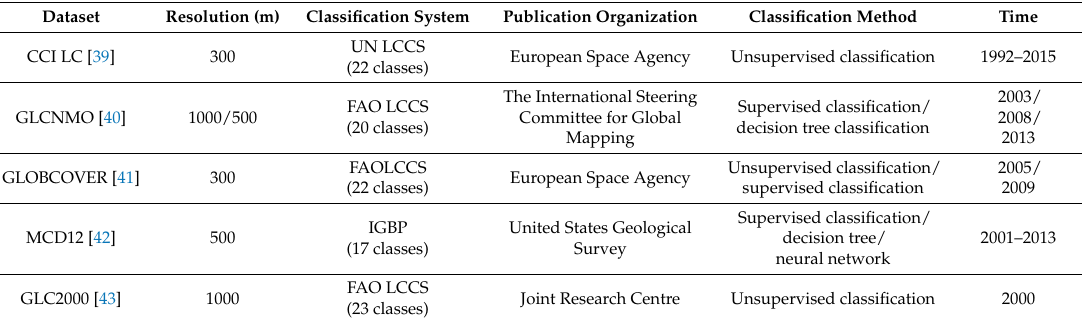
Table 1. Characteristics of the five global land-cover datasets.